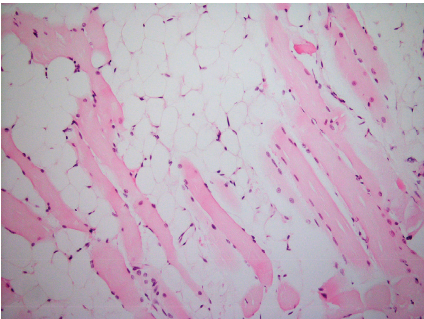
Figure 3: Histopathology ofmature adipose tissue with striated muscle fibers interspersed within (hematoxylin and eosin, original magnification × 200).